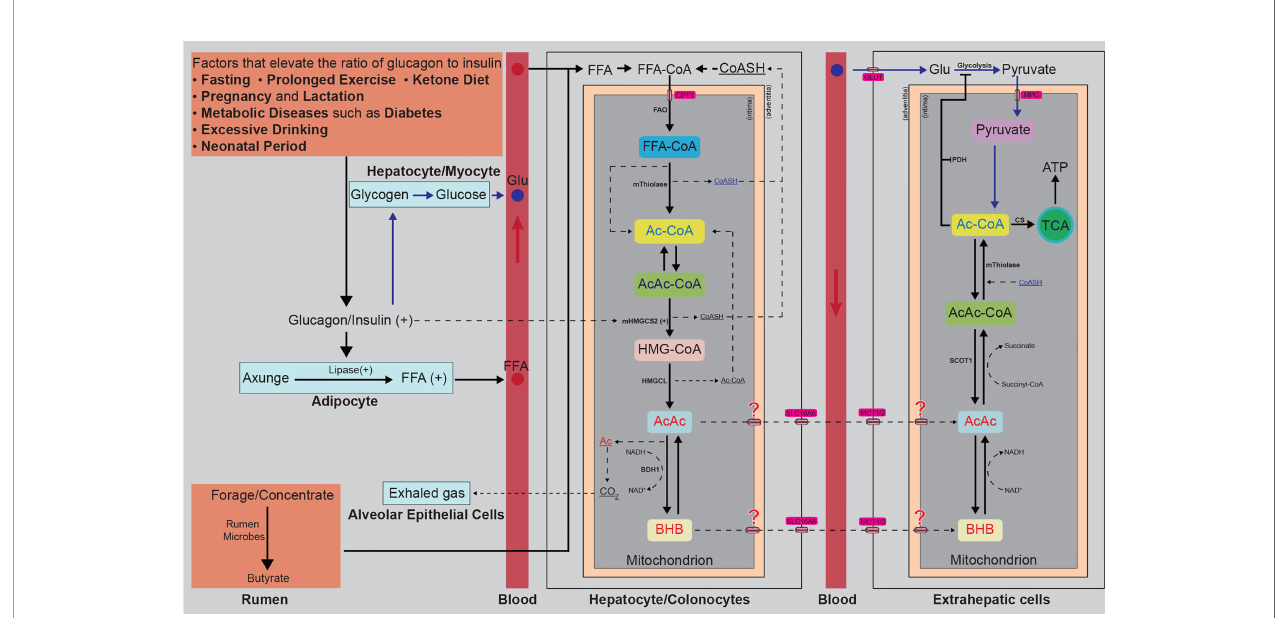
FIGURE 1 | Diagrammatic sketch of endogenous generation and consumption of BHB. Any factors that elevate the ratio of glucagon to insulin, such as fasting, prolonged exercise, insisting on a ketone diet, lactation, diabetes, or alcoholism, can accelerate the process of steatolysis and release lots of FFAs. The released FFAs are transported to the liver by albumin and are condensed with free CoASH in hepatocyte plasma. Then the condensed FFAs are transported into the mitochondrion by CPT1. The forage and concentrate englobed by ruminants are fermented into butyrate by rumen microbes and absorbed by colonocytes. The condensed FFAs and butyrate transported into the mitochondrion of hepatocytes or colonocytes are b -oxidated into Ac-CoA, two of which are further condensed into an AcAc-CoA, releasing a CoASH. The Ac-CoA and AcAc-CoA are then catalyzed to condense into HMG-CoA by mHMGCS2, encoded by a strictly spatiotemporally controlled gene ( mHMGCS2 ). The HMG-CoA is cleaved into Ac-CoA and AcAc by HMGCL. The AcAc is reduced into D-BHB by BDH1 (consuming NADH and releasing NAD + ) or spontaneously decarboxylated to volatile acetone and CO 2 , released into the bloodstream by free diffusion and easily eliminated through the alveolar epithelial cells in the lung. Ac and AcAc are released into circulating blood. The D-BHB is transported across the mitochondrial intima through a yet-unknown mechanism and across the mitochondrial adventitia by SLC16A6 and released into the circulating blood. AcAc and BHB are absorbed by extrahepatic cells. BHB is oxidated to AcAc by BDH1 (consuming NAD + and releasing NADH, a reversible reaction that also occurs in the generation process of BHB), and AcAc is activated into AcAc-CoA by SCOT1 (succinyl-CoA donates the CoA), and then split into Ac-CoA by mThiolase, consuming CoASH. The glucose derived from the glycogen is transported to and absorbed into the extrahepatic cells by GLUT. In the cytoplasm, the glucose is oxidated into pyruvate by glycolysis, inhibited by the BHB-derived Ac-CoA. Pyruvate is transported into the mitochondrion and then dehydrogenated to Ac- CoA by PDH, inhibited by the BHB-derived Ac-CoA. The BHB and pyruvate-derived Ac-CoA enter the TCA circle or act as signalling molecules. CoASH, coenzyme A; FFAs, free fatty acids; CPT1, carnitine palmitoyltransferase 1; FAO, fatty acids b -oxidation; Ac-CoA, acetyl-CoA; AcAc-CoA, acetoacetyl-CoA; mHMGCS2, mitochondrial 3- hydroxymethylglutaryl-coenzyme A synthase; HMG-CoA, hydroxymethylglutaryl-CoA; HMGCL, hydroxymethylglutaryl coenzyme A lyase; Ac, acetone; AcAc, acetoacetate; BHB, b -hydroxybutyrate; NADH/NAD + , nicotinamide adenine dinucleotide; SLC16A6, solute carrier family 16 member 6; MCT, monocarboxylate transporters; OXCT1, 3- oxoacid-CoA transferase 1; GLU, glucose; GLUT, glucose transporter; MPC, membrane permeation channel; CS, Citrate Synthase; TCA, tricarboxylic acid; ATP, adenosine